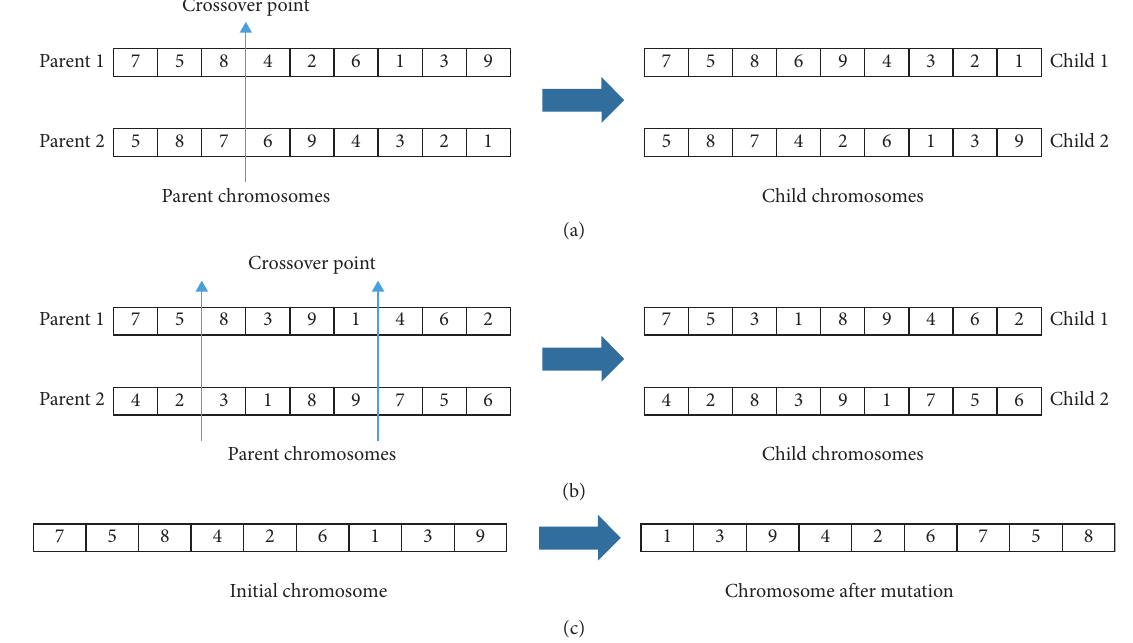
Figure 10: Crossover and mutation operators: (a) single-point crossover. (b) Two-point crossover. (c) Swap